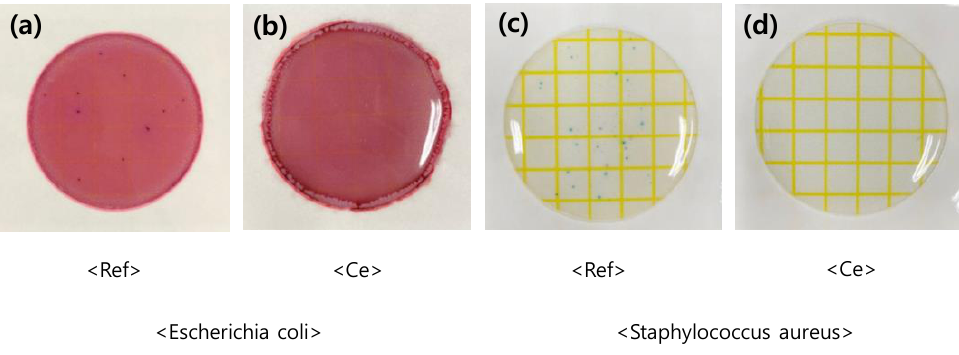
Figure 6. Antimicrobial test of sample of ( a ) ref sample, ( b ) Ce sample, ( c ) Ref sample and ( d ) Ce sample.